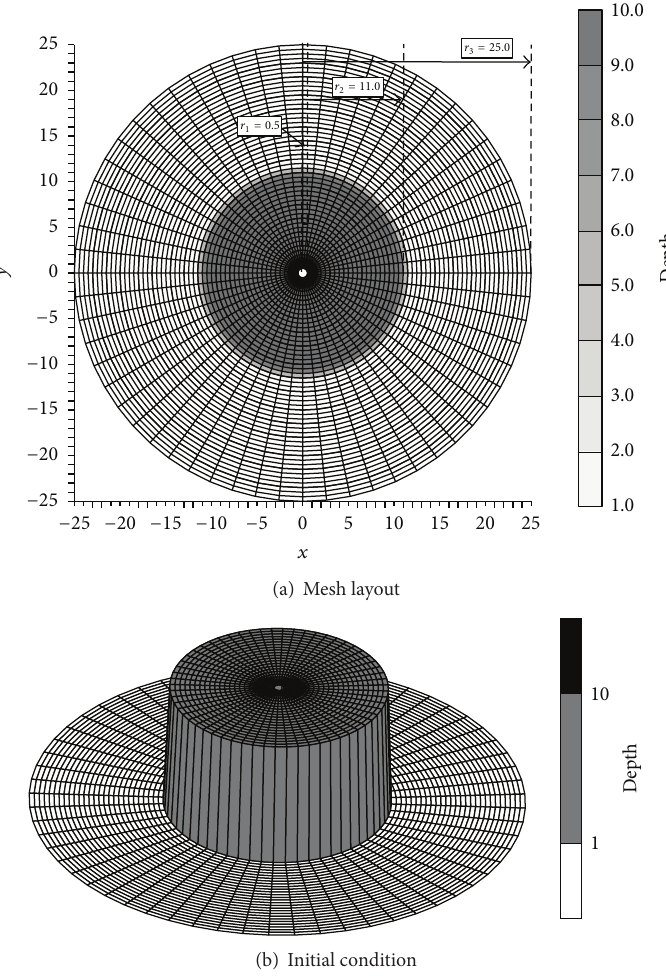
Figure 6: Mesh layout and initial condition for cylinder breaking simulation (unit of depth: